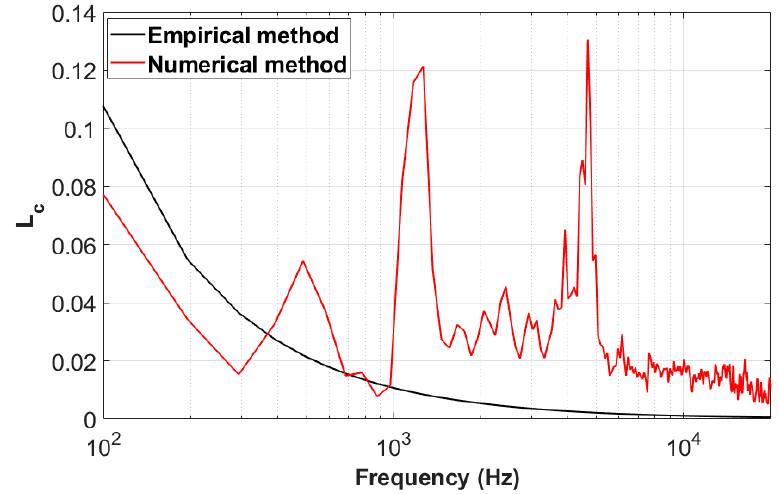
Figure 5. Comparison of the spanwise coherence length between the results computed based on IDDES data and the empirical Corcos model.